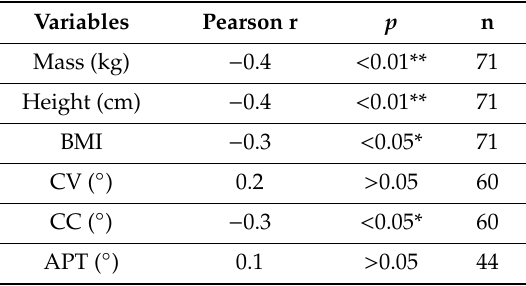
Table 4. Correlation of anthropometric and kinematic parameters with anterior COG shift. Variables Pearson r